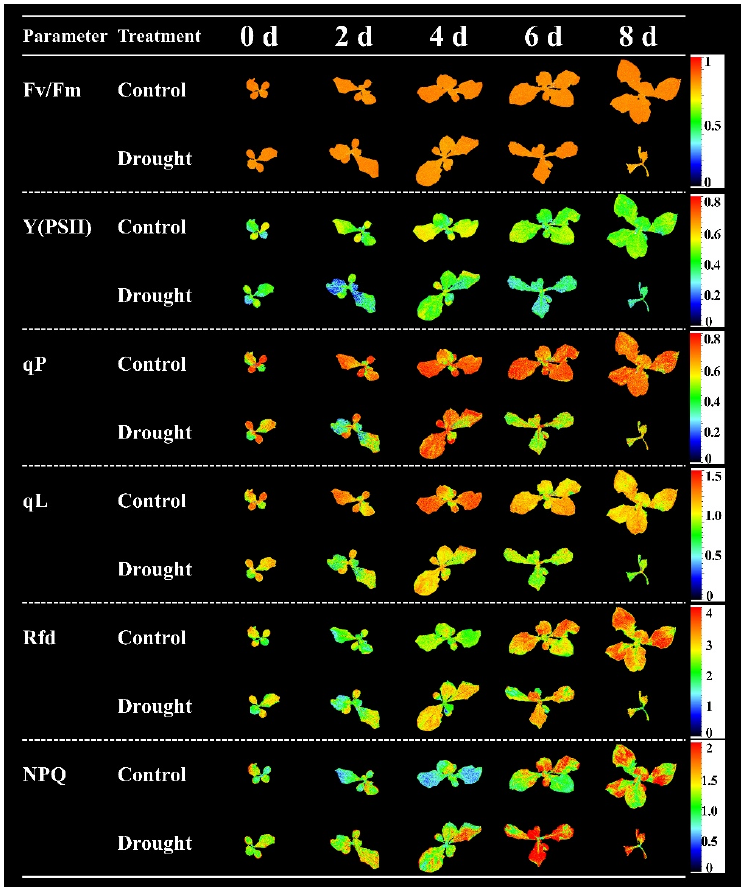
Figure 3. Changes in CF images: F v /F m , qP, QY_Lss, NPQ, and Rfd in lettuce seedlings grown under drought condition for different time periods. Refer to Table 1 for descriptions of each CF parameter.